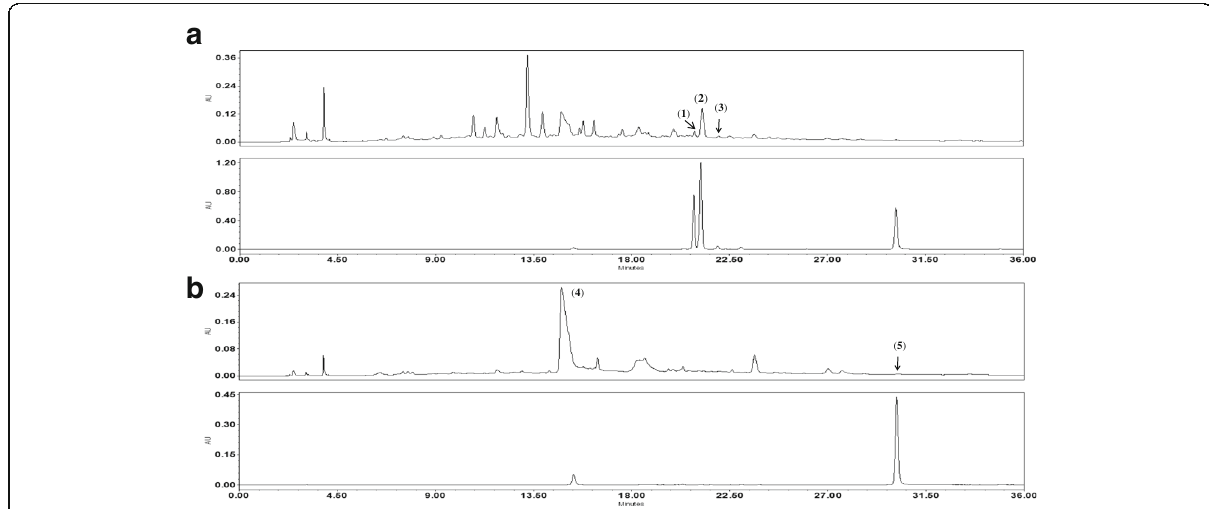
Fig. 2 HPLC chromatogram standard mixture and DHSMT. a 330 nm and b 400 nm. (1) nodakenin, (2) ferulic acid, (3) sophoricoside, (4)